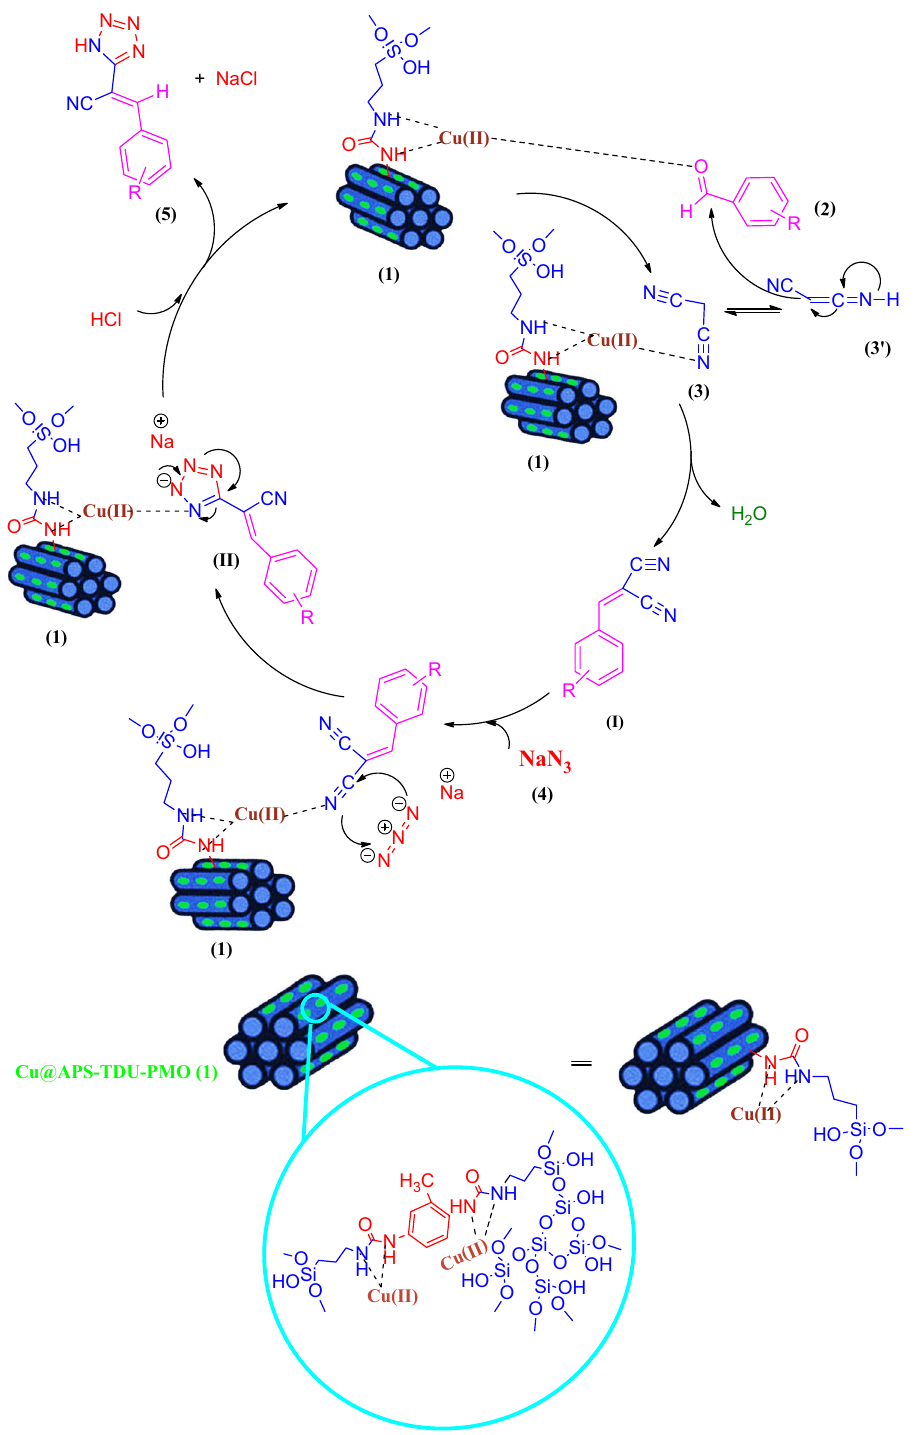
Figure 8. The proposed mechanism for the synthesis of 2-(1 H -tetrazol-5-yl) acrylonitrile derivatives in the presence of Cu@APS-TDU-PMO nanoreactor ( 1